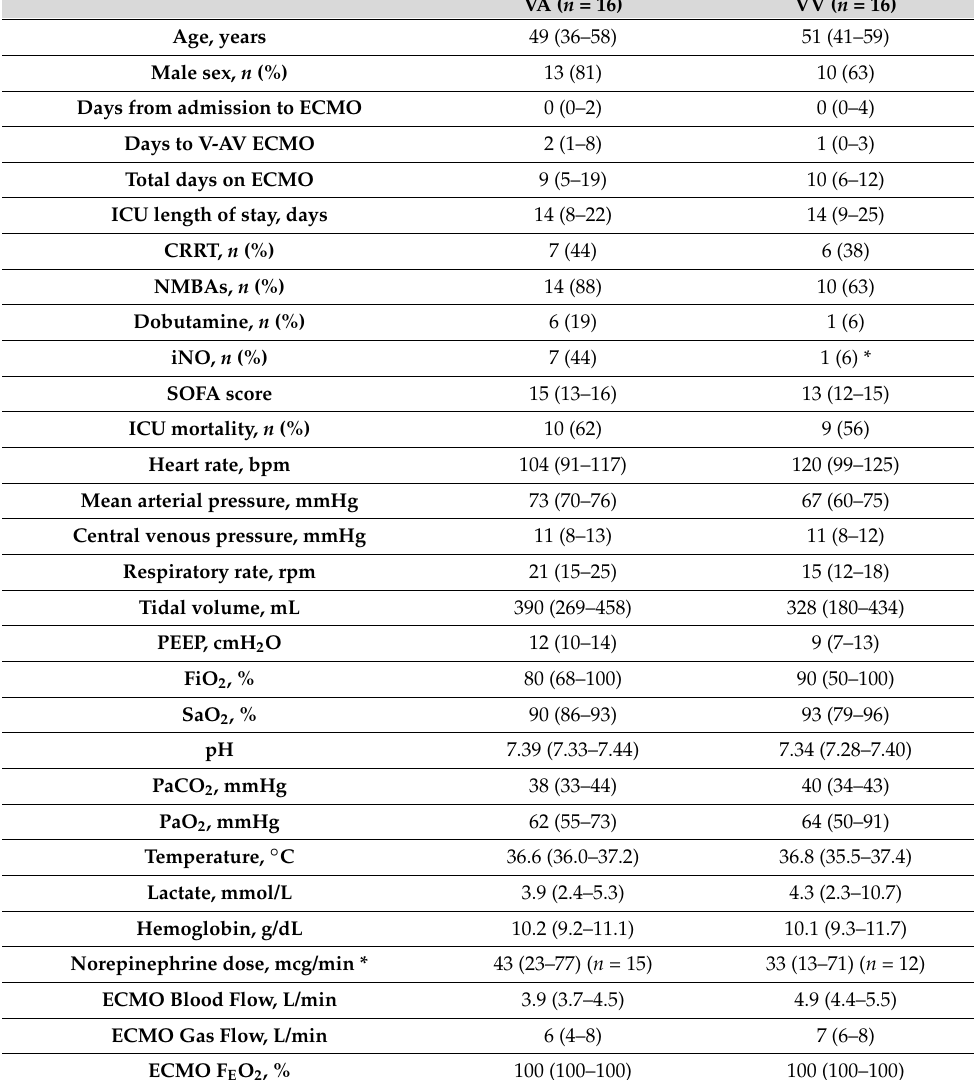
Table 2. Characteristics of the study population, according to the initial ECMO configuration (VA = veno-arterial; VV = veno-venous). Data are presented as count (percentage) or median [IQRs].